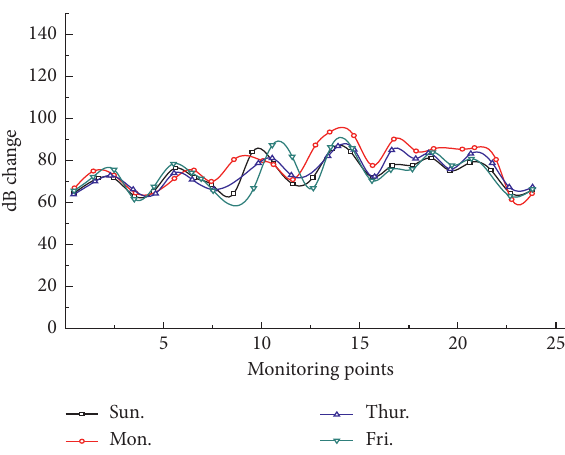
Figure 3: Noise levels at 7 a.m. for the 24 measuring points.